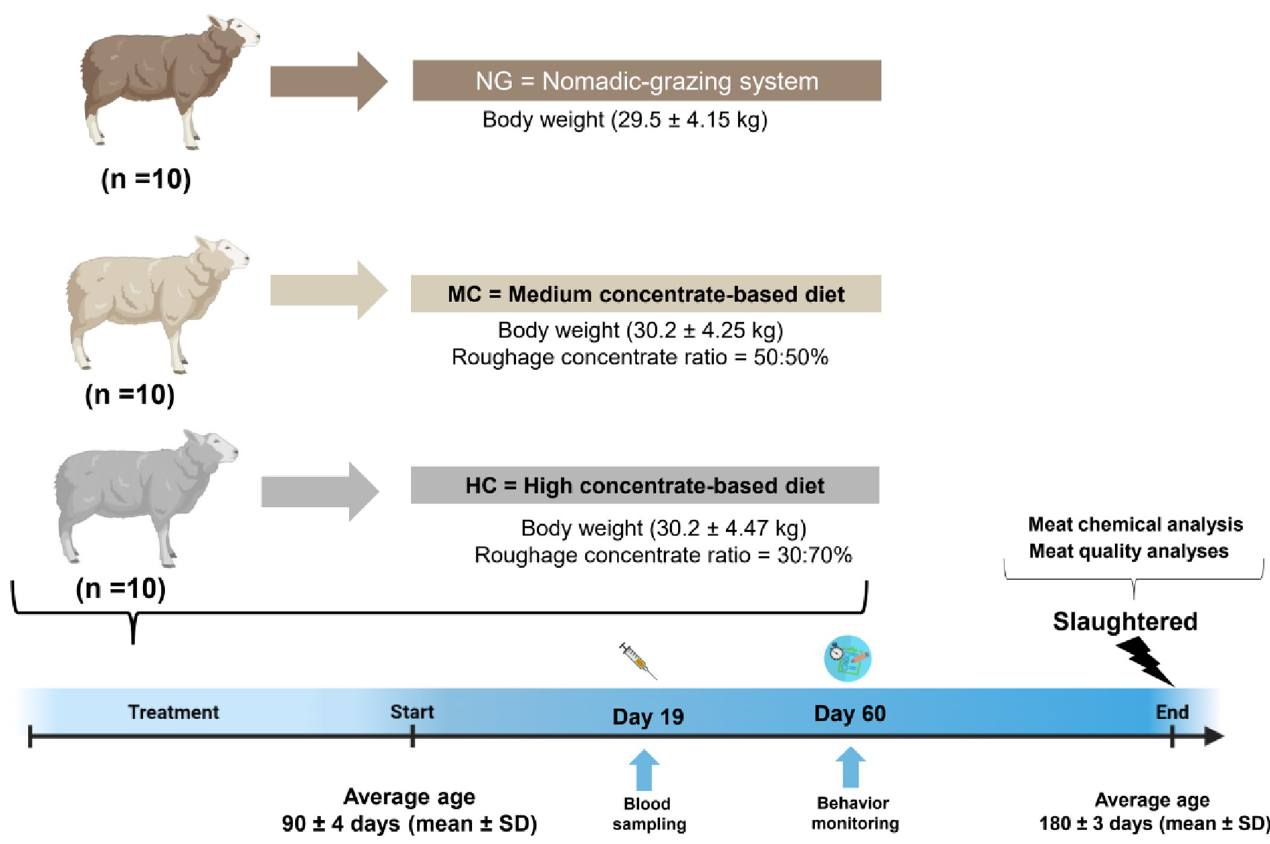
Fig 1. Overview of the animal experiment. The objective of the study was to evaluate the effects of three production systems on growth performance, behaviour, chemical characteristics, carcass, and meat quality. A total of 30 lambs (n = 10 lambs/treatment) were randomly assigned to three production systems that included nomadic grazing (NG) and two different levels of concentrates (CON) one with medium (MC, 50% concentrate) and another with high concentrate (HC, 70% concentrate). At the beginning of the experiment, all lambs averaged 90 ± 4 days of age (mean ± SD) and were slaughtered at an average of 180 ± 3 days of age (mean ± SD). The Figure was designed by BioRender online software (https://app.biorender.com).